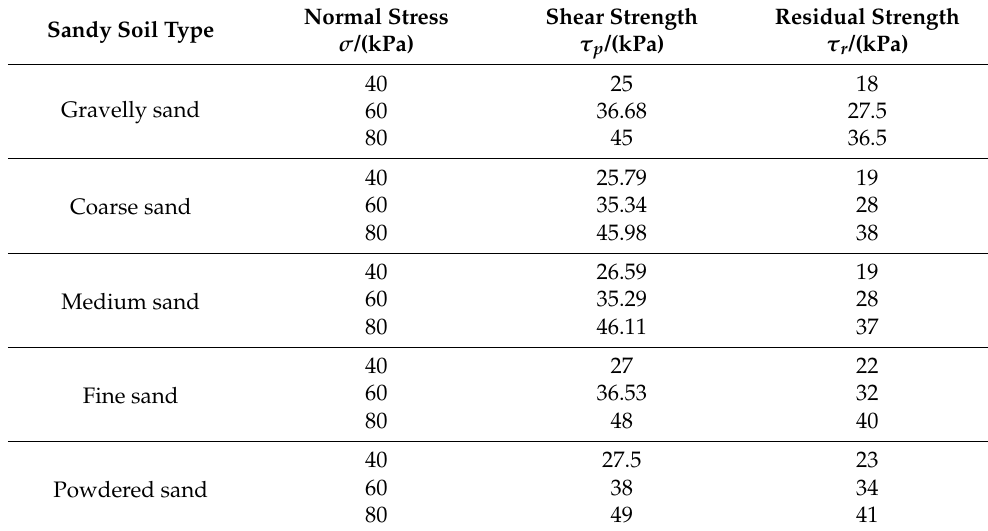
Table 2. Data of shear strength and residual strength of sand–steel interface with different parti- cle sizes.